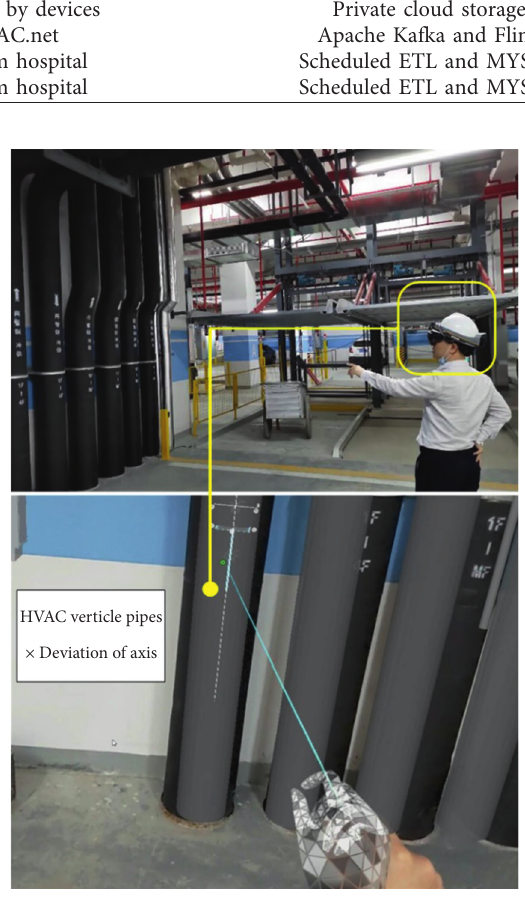
Figure 4: On-site object checking by MR